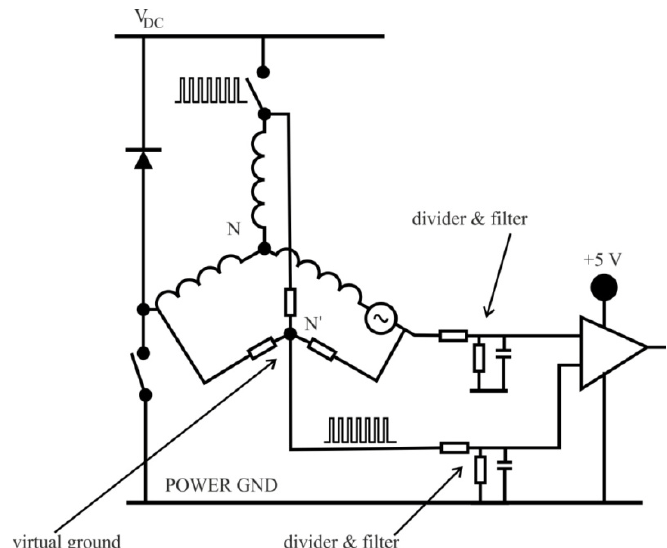
Figure 13. Back-EMF sensing based on virtual neutral point